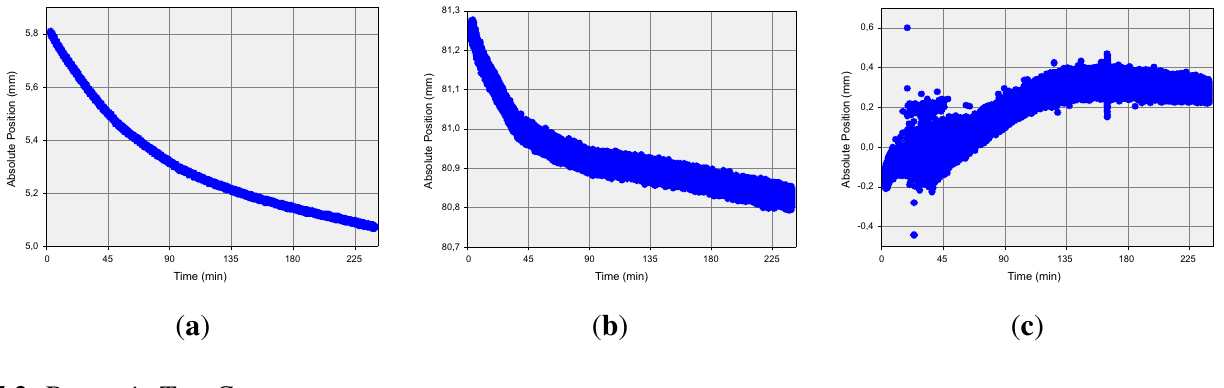
Figure 6. Long Time Measurement: Change of (a) x-, (b) y- and (c) z-Coordinate over